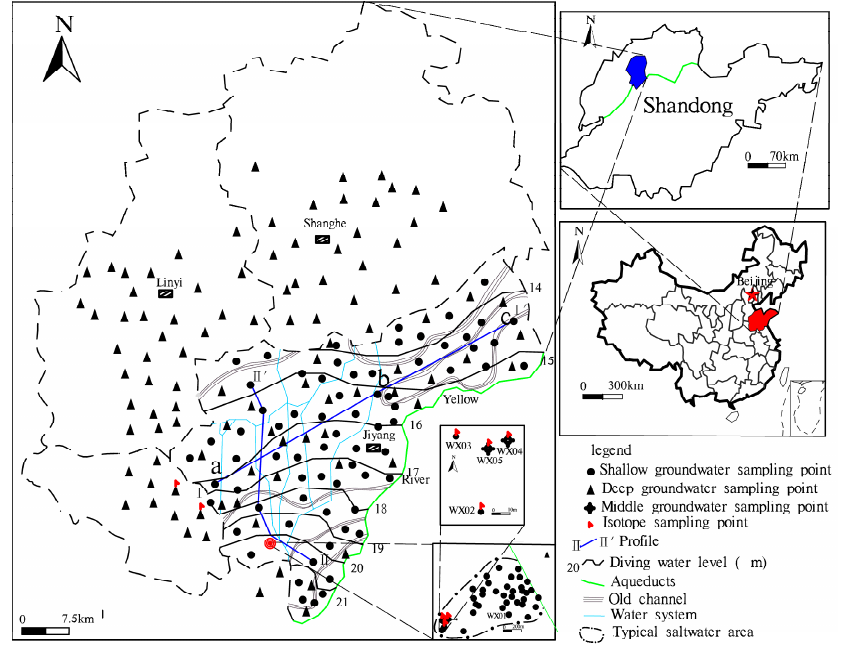
Figure 1. The sketch map of the groundwater flow field and the detection point in the study area.